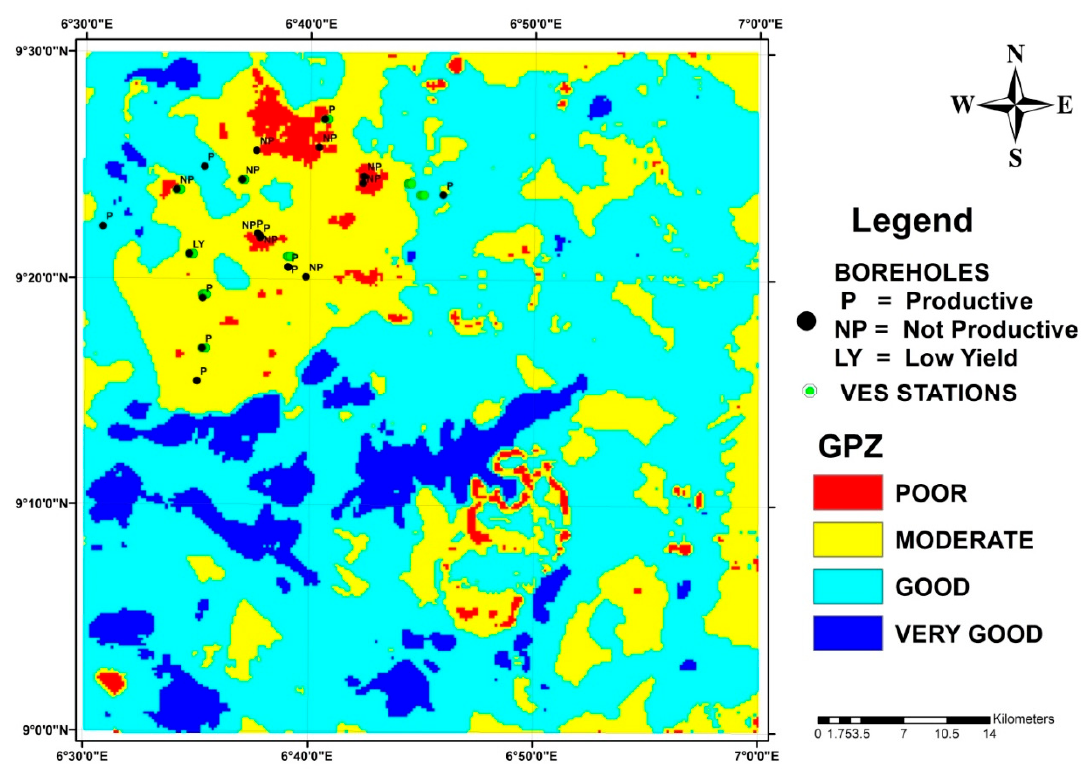
Figure 10. Groundwater Potential map of Paiko Sheet 185 North Central Nigeria showing four categories of groundwater potential zones. Regions in red show poor groundwater potential zones while areas in blue show very good groundwater potential zones.